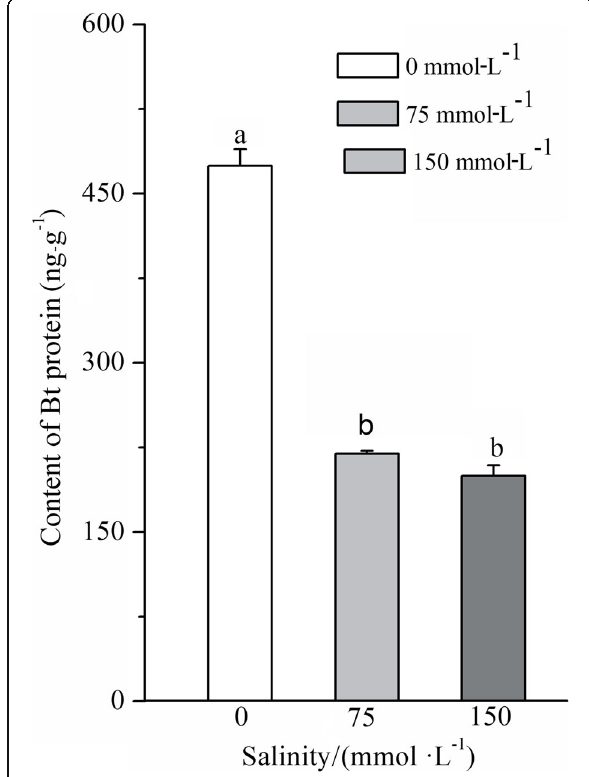
Fig. 1 Effects of NaCl stress on Bt protein expression in Bt cotton. Mean ± (SE); Significant difference in lowercase letters at 0.05 level between NaCl stress